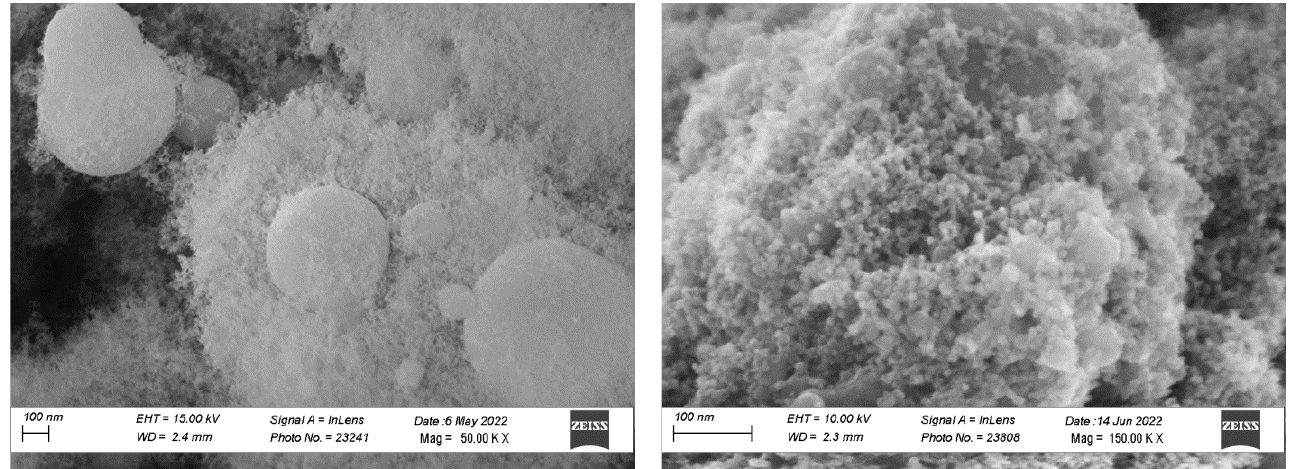
Figure 2. SEM image of synthesized cobalt oxide powder prepared by the flame spray method.